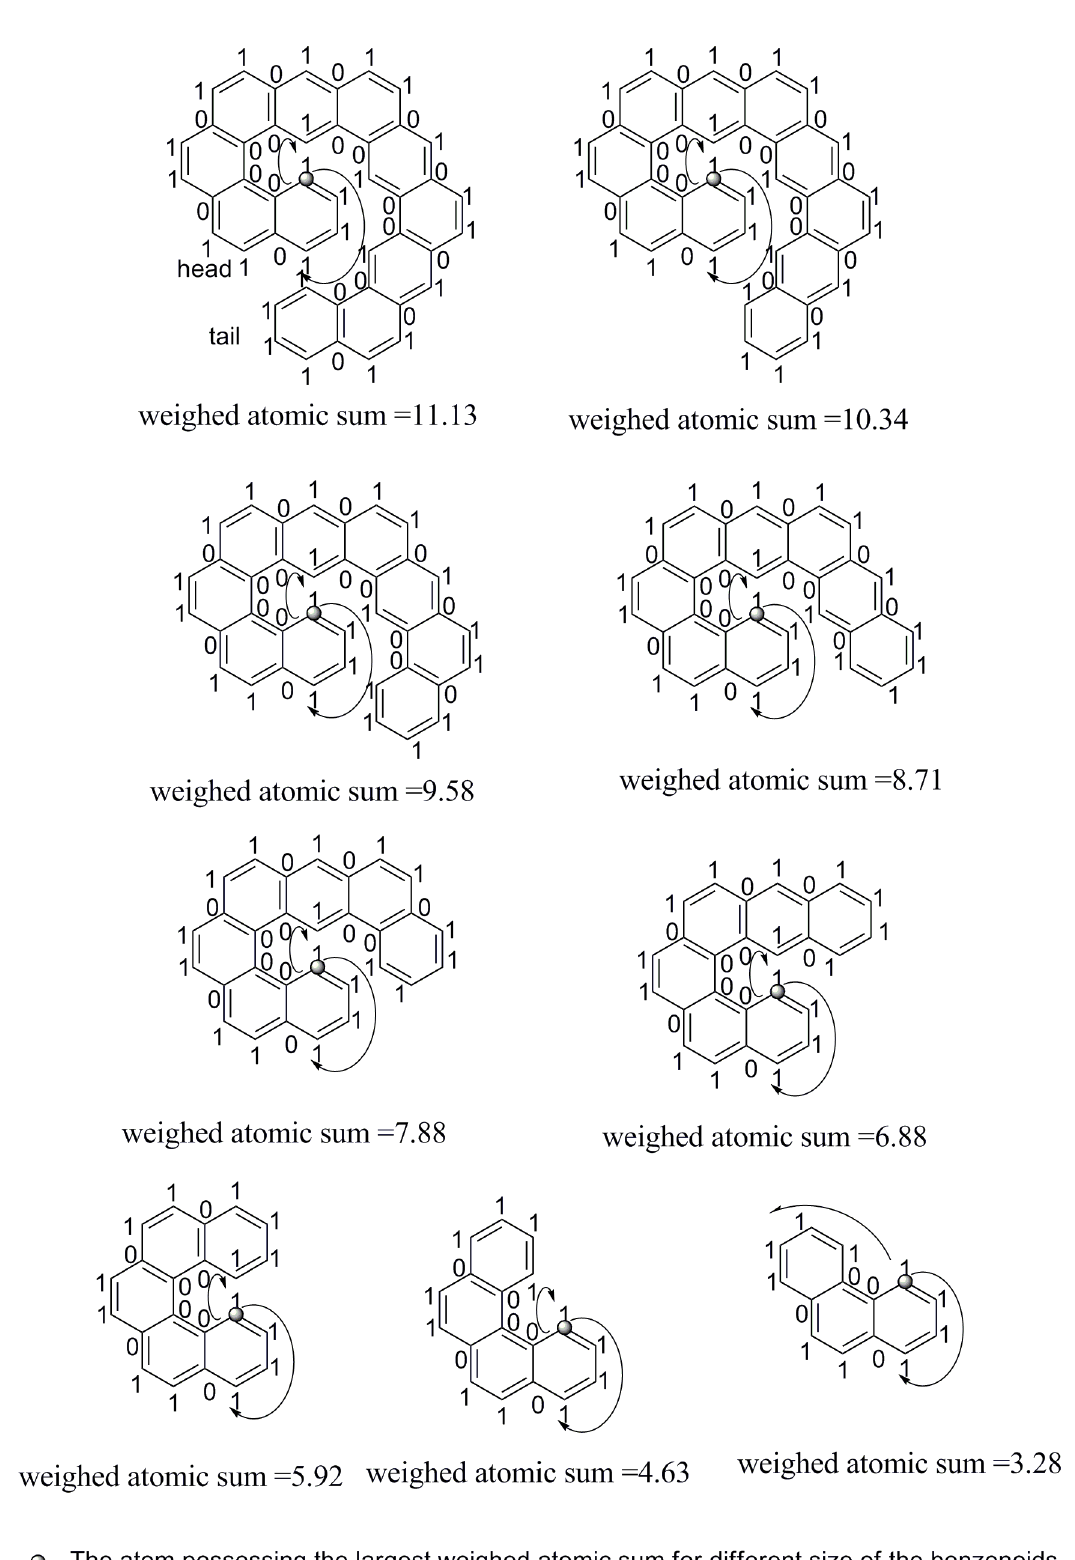
Descriptors of Atomic Asymmetry and Molecular Chirality in 2D Space